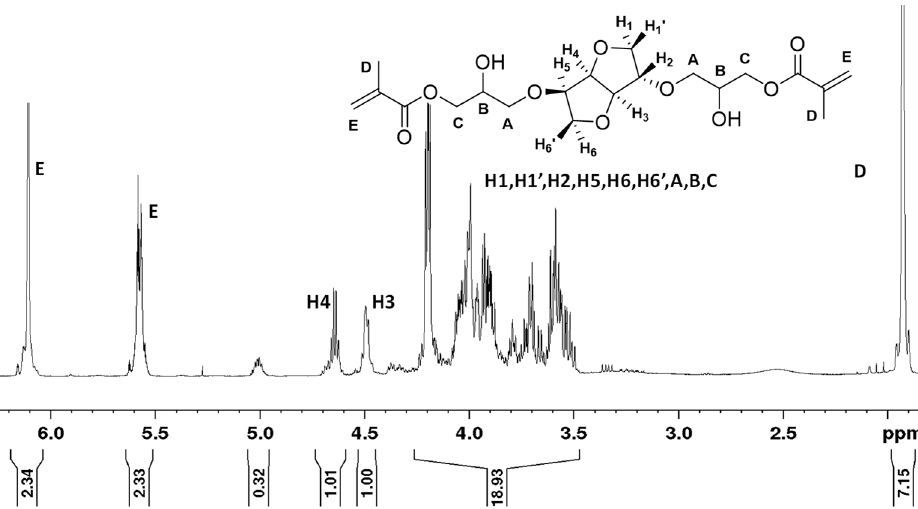
Figure 8. 1 H Isosorbide 2,5-bis(glyceryloxy) dimethacrylate.